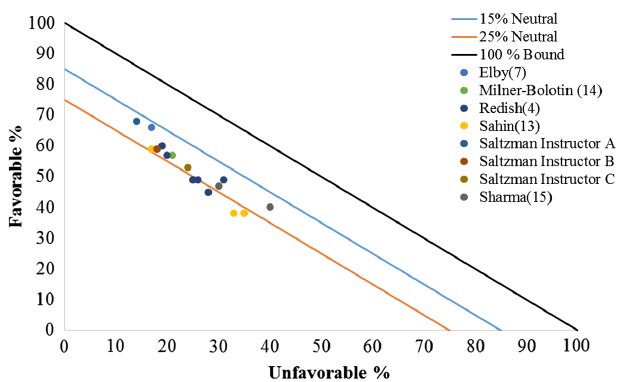
FIG. 2. FAV/UNFAV plot of postinstruction results with those results from previous studies of MPEX and